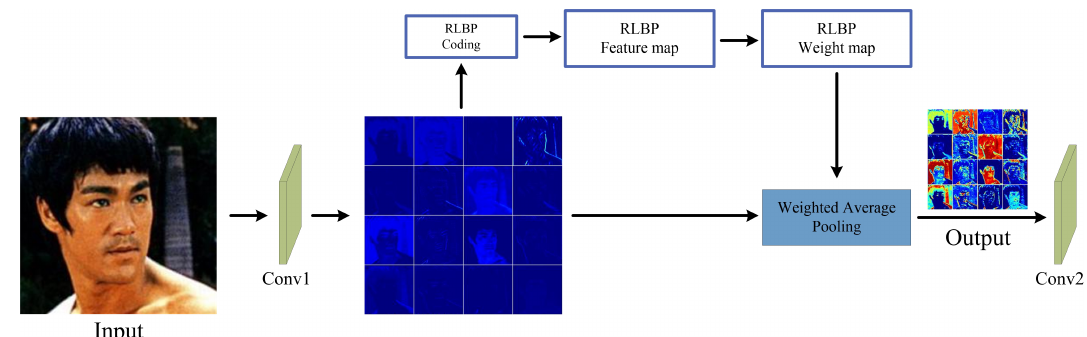
Figure 2. The structure of the G-RLBP pooling layer.